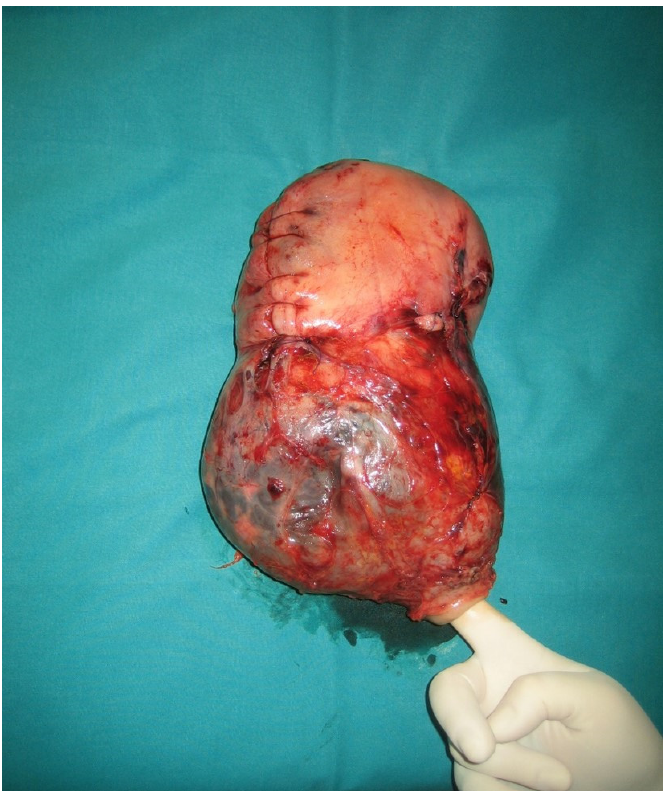
Figure 2. Macroscopic surgical specimen. The uterine cervix is indicated by the surgeon’s finger on the lower side. Above the cervix, the lower uterine segment is bulging because of the presence of placenta previa accreta with evidence of reduced myometrial thickness and massive neovascularization. On the upper uterine corpus, longitudinal caesarean section scar avoiding the placental edge is shown.